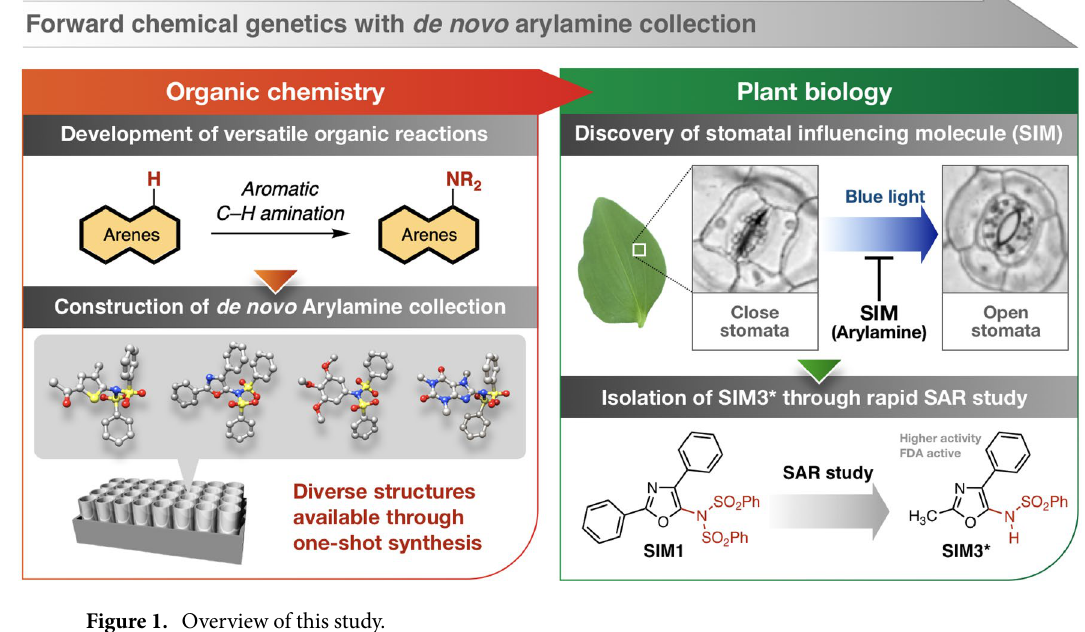
Figure 1. Overview of this